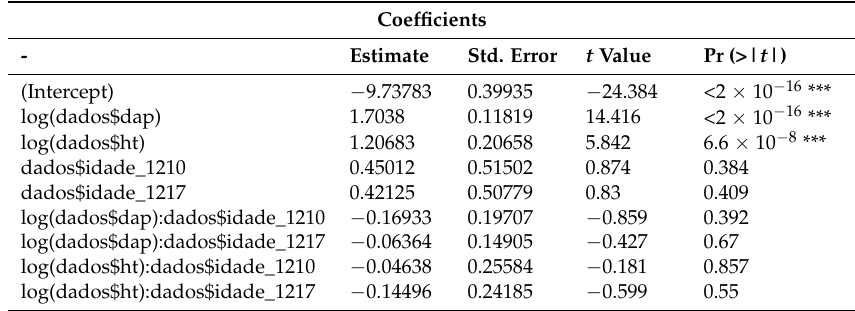
Table A6. R software output table with ANCOVA significance values resulting for volume using C 12 as reference for comparison of C 10 and C 17.